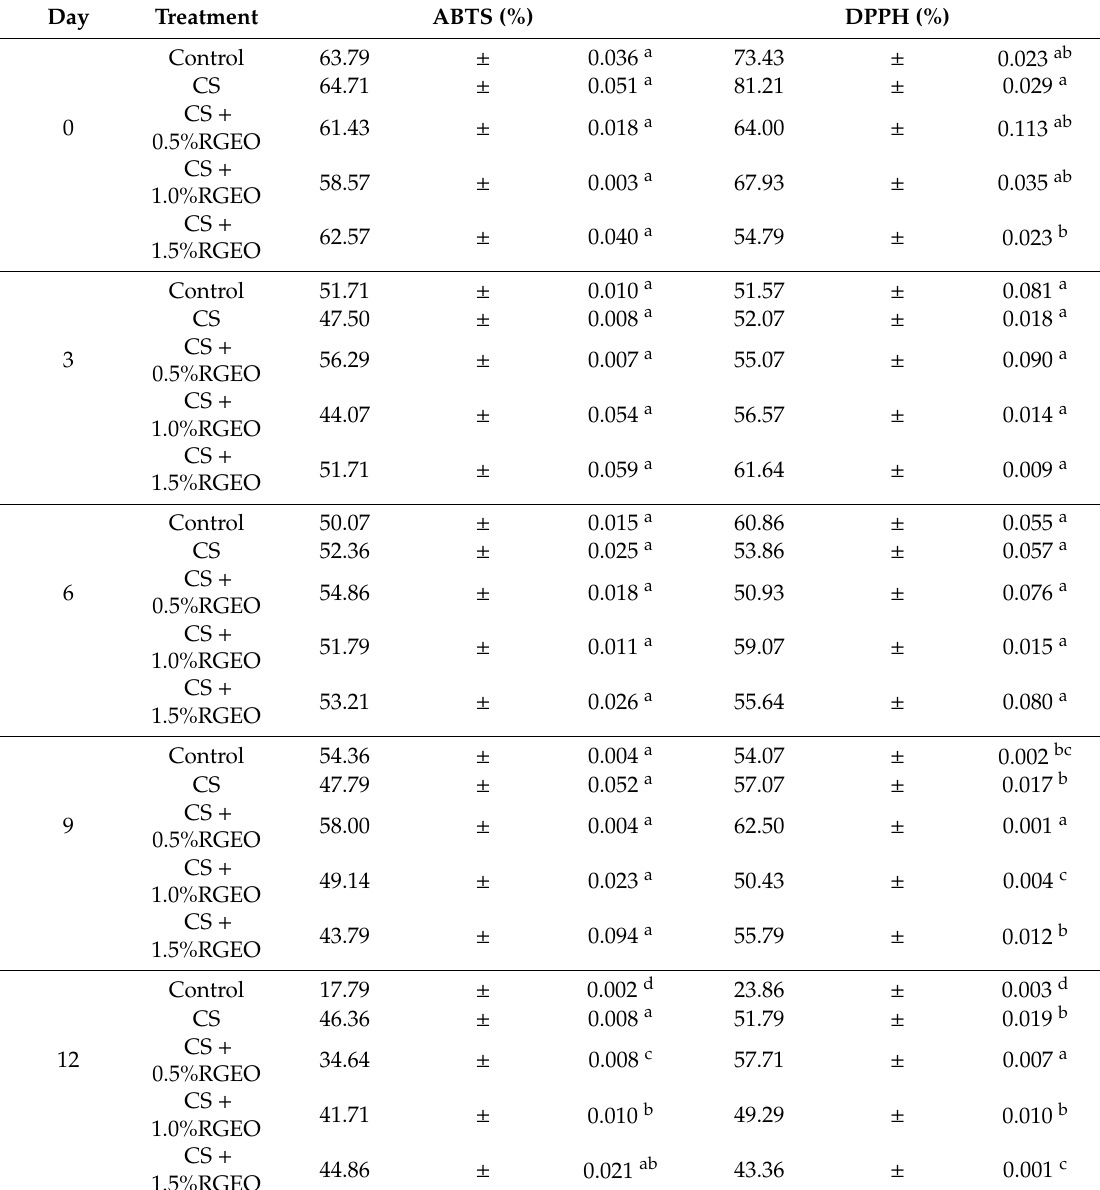
Table 3. Antioxidant capacity expressed as a percentage of inhibition by the 2,2 (cid:48) -azinobis-(3-ethyl-benzothiazoline-6-sulphonic acid) (ABTS) and DPPH